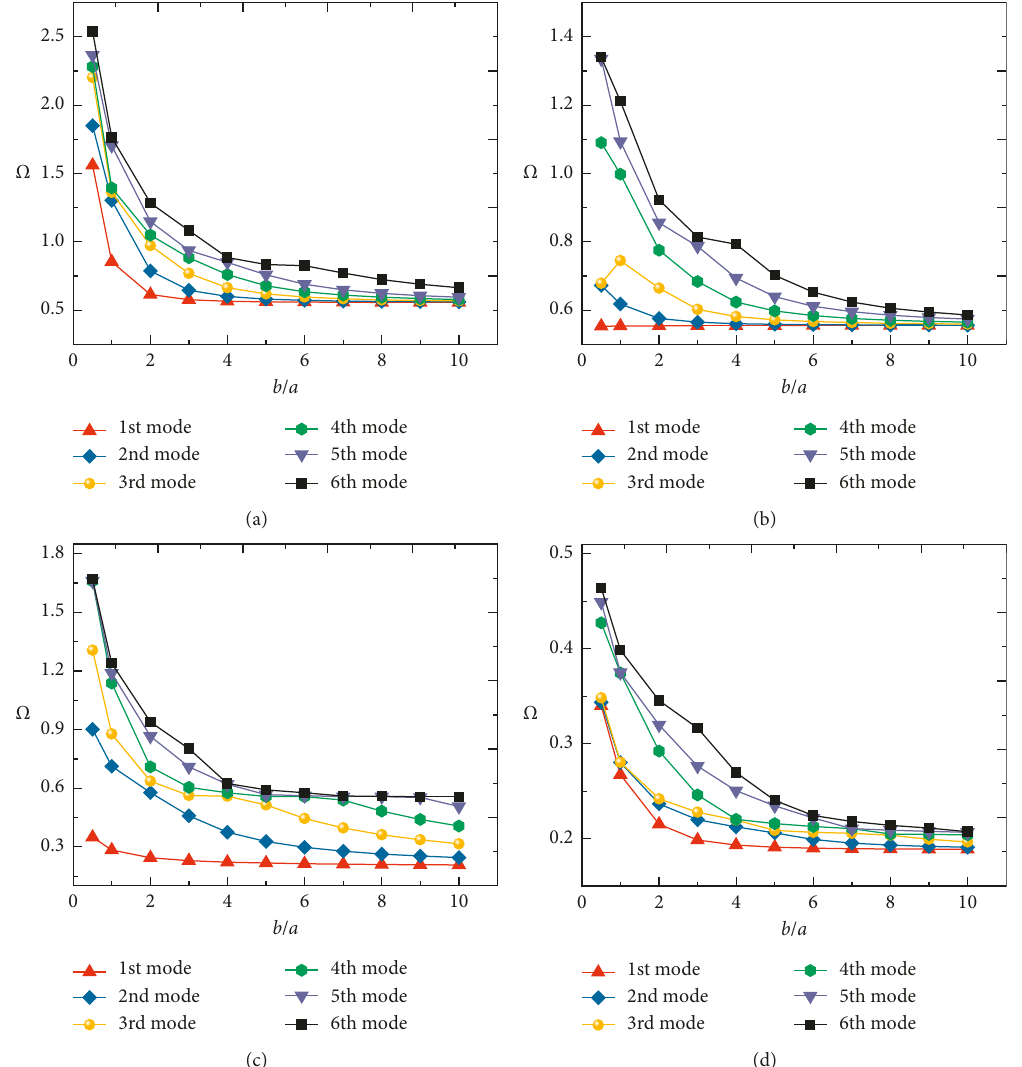
Figure 10: Variations of nondimensional frequency parameter (a) CCCC; (b) CFCF; (c) E2E2E2E2; (d) E4E4E4E4.